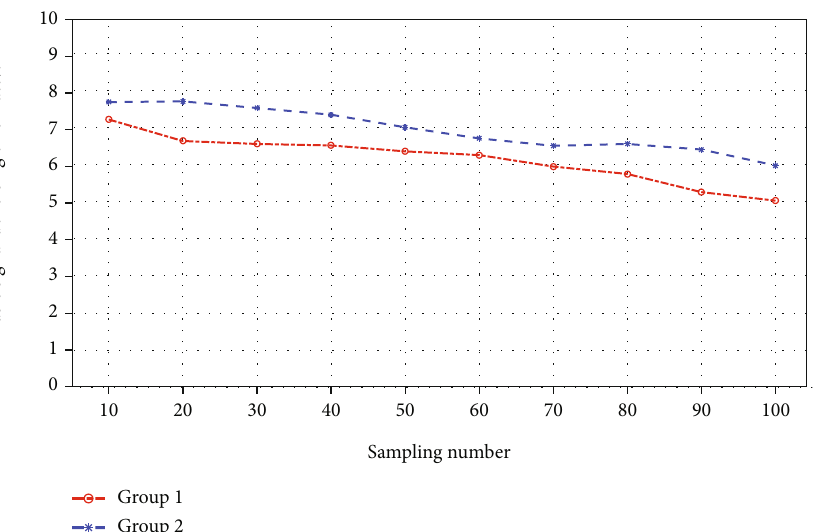
Figure 6: Line chart of comparison of music signal denoising error rate.